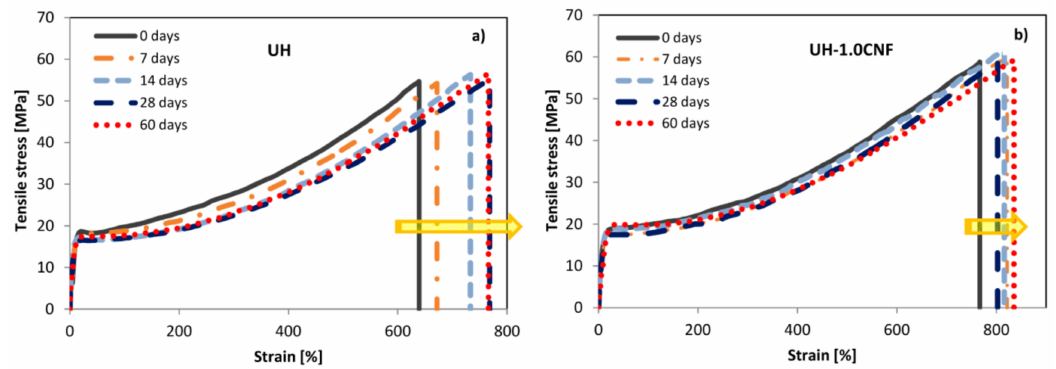
Figure 4. Representative stress/strain curves of UH ( a ) and UH-1.0CNF ( b ) during the 60 days of immersion